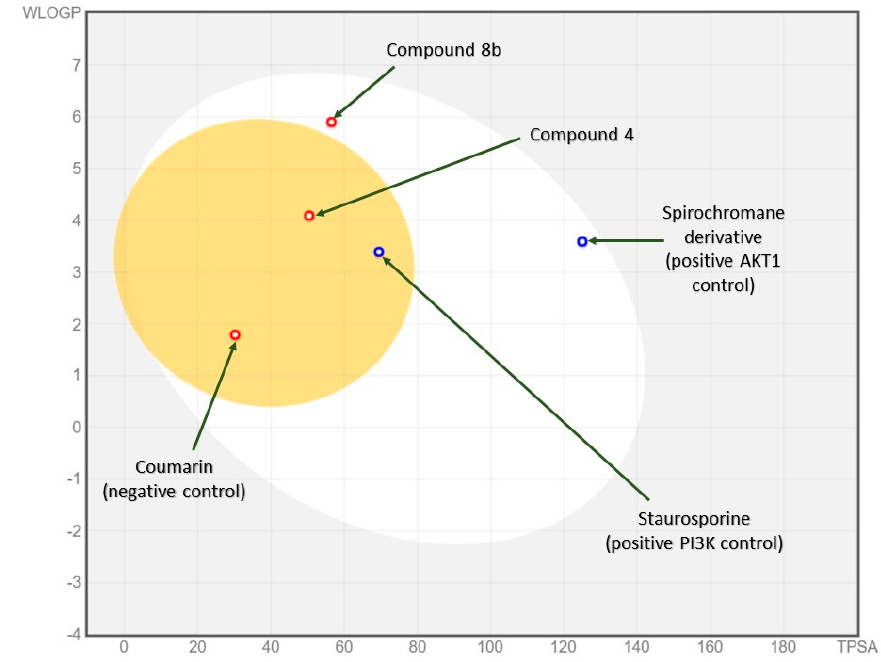
Figure 14. BOILED-Egg model: A) compound ( 4 ) and B) compound ( 8b ).